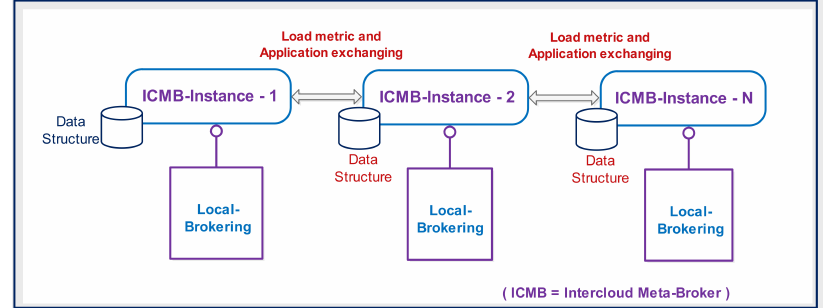
Figure 5. Meta-brokering information